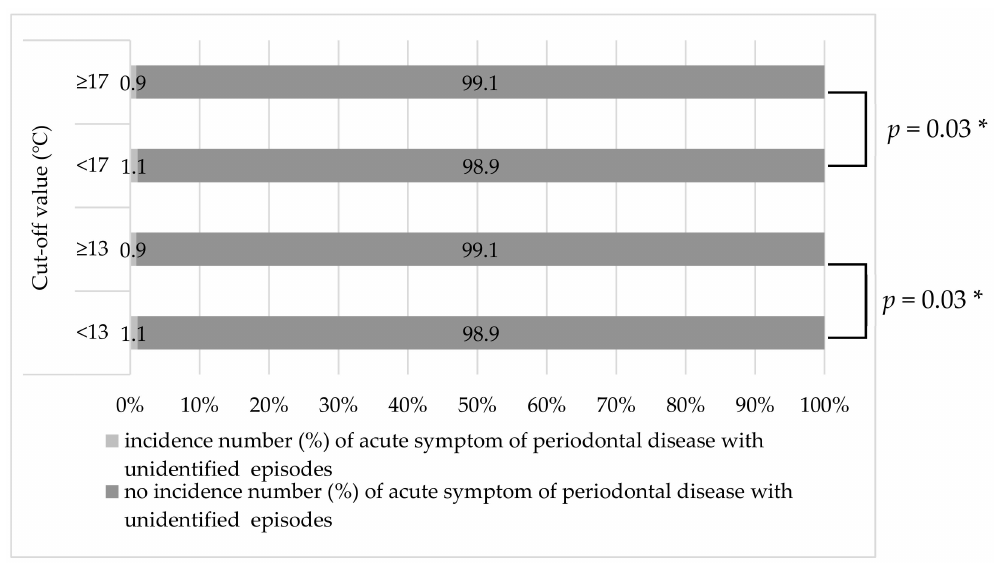
Figure 3. Evaluation of the two cut-o ff values of the mean daily temperature to predict the incidence of the acute symptom of chronic periodontal disease. * Chi-squared